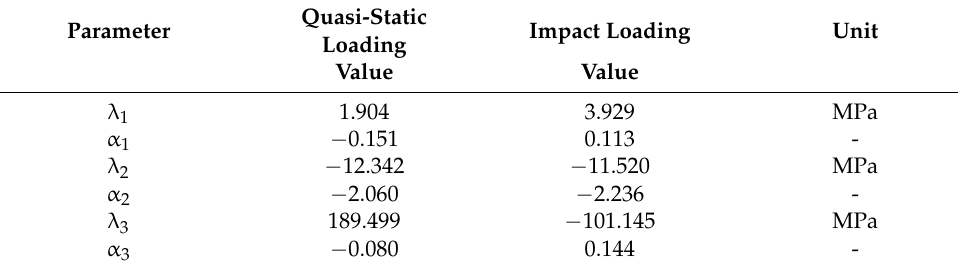
Table 2. Ogden 3rd-order factored parameters.